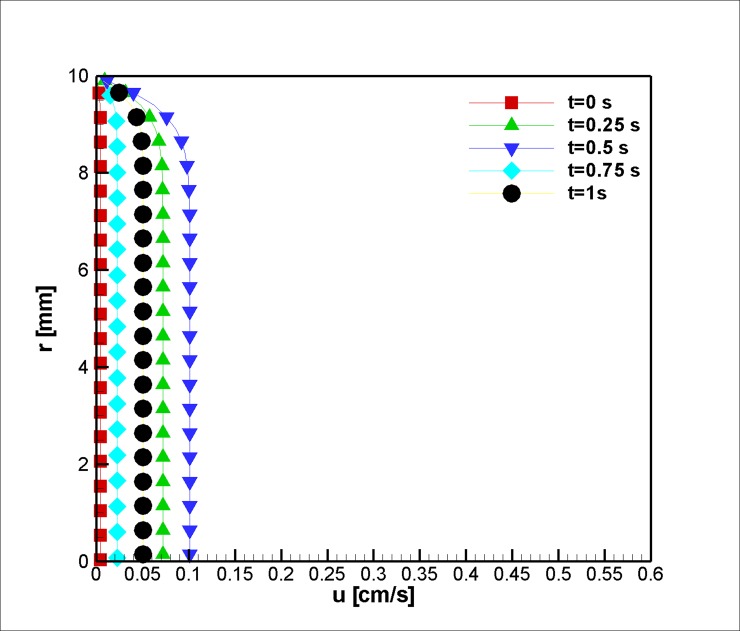
Velocity in axial direction at z = 4 cm for the case of Joule heating, Lvessel = 7 cm, Rvessel = 1 cm and fifty percent stenosis.